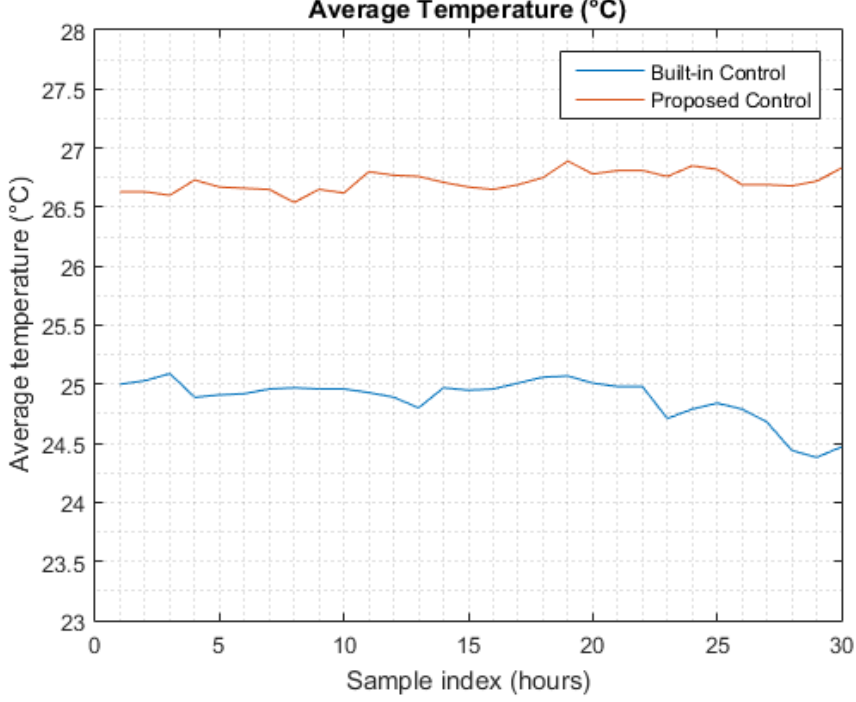
Figure 13. Average temperature with the built-in and proposed control systems.